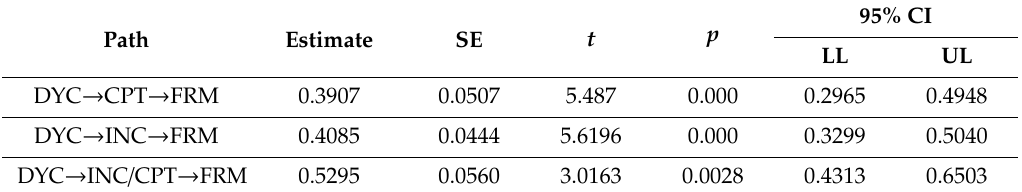
Table 4. Indirect e ff ects through factors of CPT and INC using the bootstrap Table 4. Indirect effects through factors of CPT and INC using the bootstrap method.